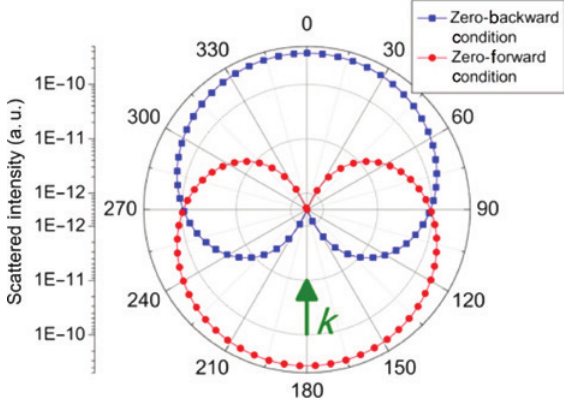
Figure 21: A cardioid radiation pattern from a nanosphere that satisfies the first Kerker condition (obtained from